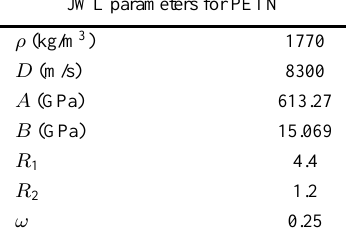
JWL parameters for PETN